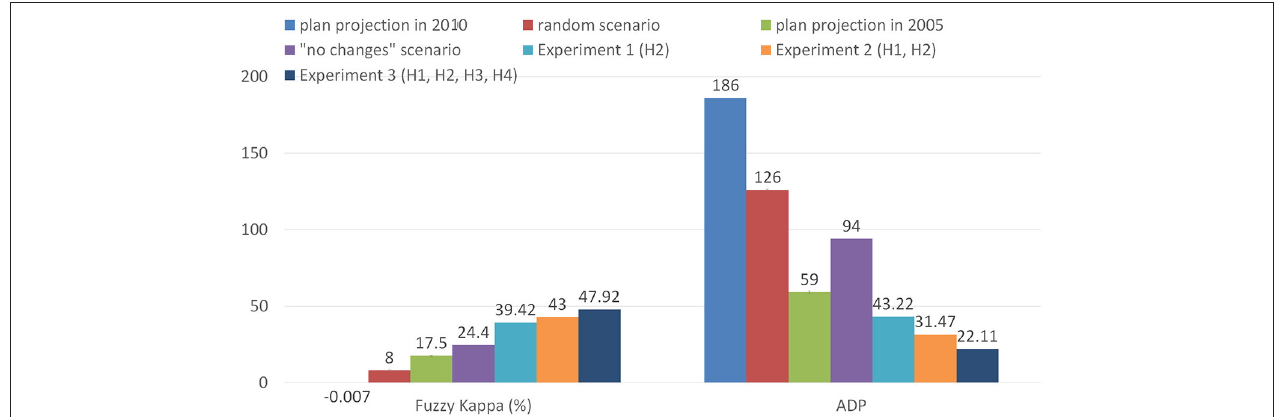
FIGURE 14 | Comparison of the FKappa and ADP indicators of the three